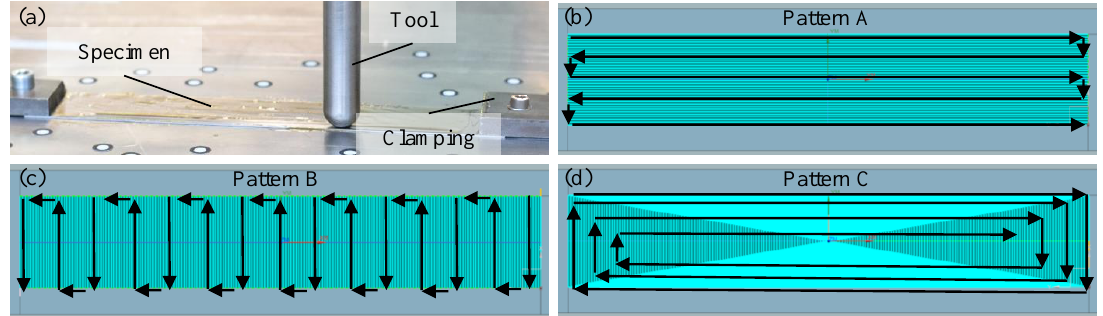
Figure 2. Experimental setup ( a ) and tested tool path Patterns A–C ( b–d ); blue lines, real tool path; black lines with arrows, simplified representation of the tool path.